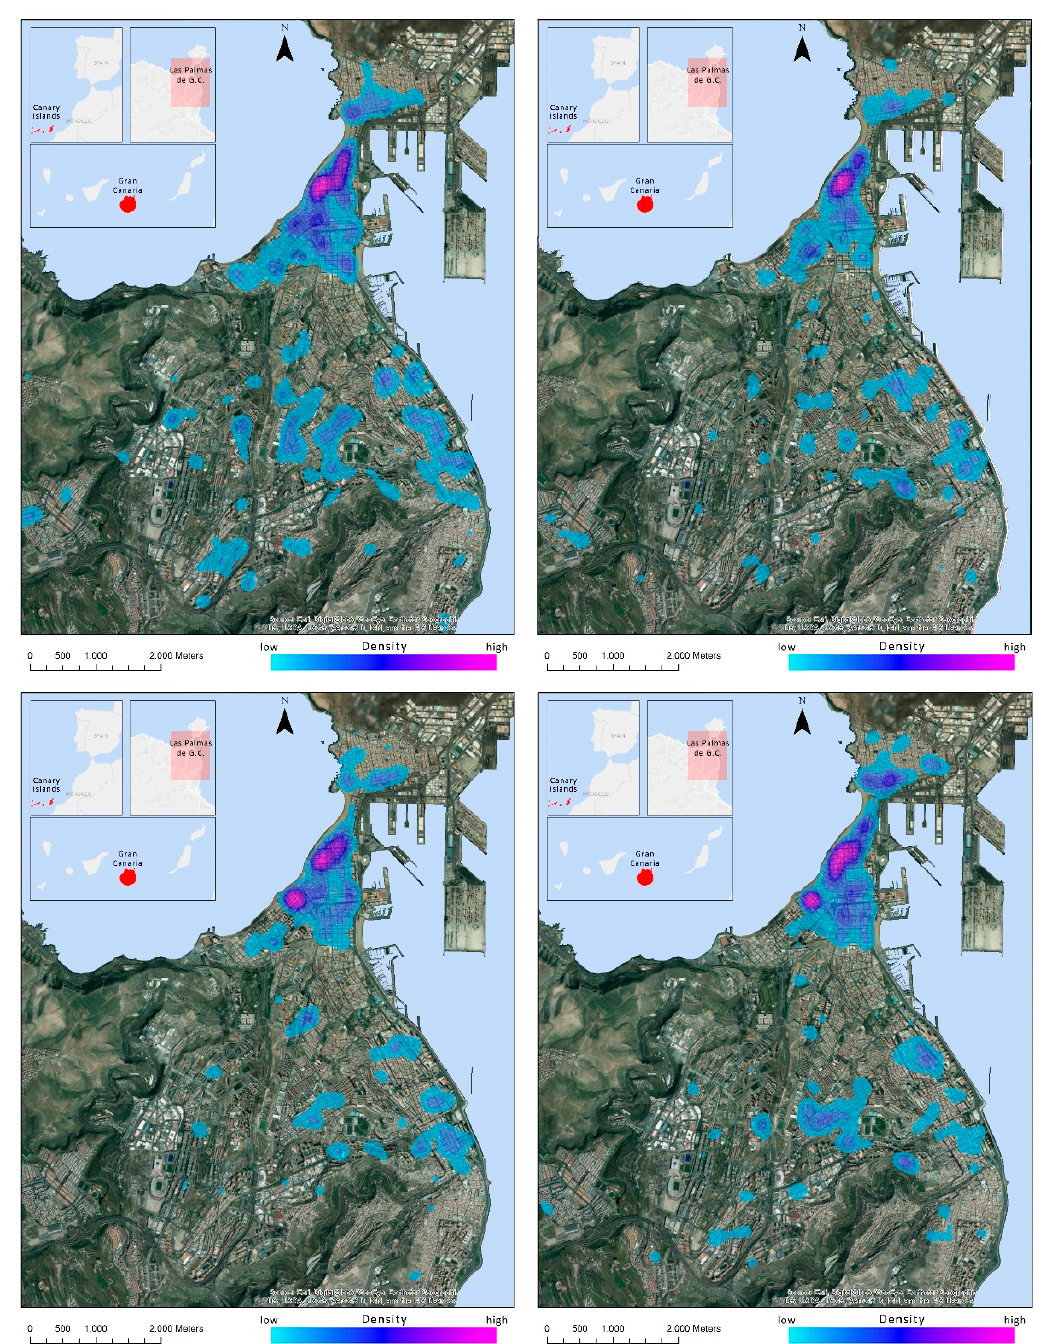
Figure 6. Distribution of the dispossessions between 2009 and 2013 ( top left ) and 2014 and 2017 ( top right ) and the losses of use between 2009 and 2013 ( bottom left ) and 2014 and 2017 ( bottom right ) in Las Palmas de Gran Canaria. Data: Common Service of Notifications and Liens of the Judicial District for Las Palmas de Gran Canaria. Own production.